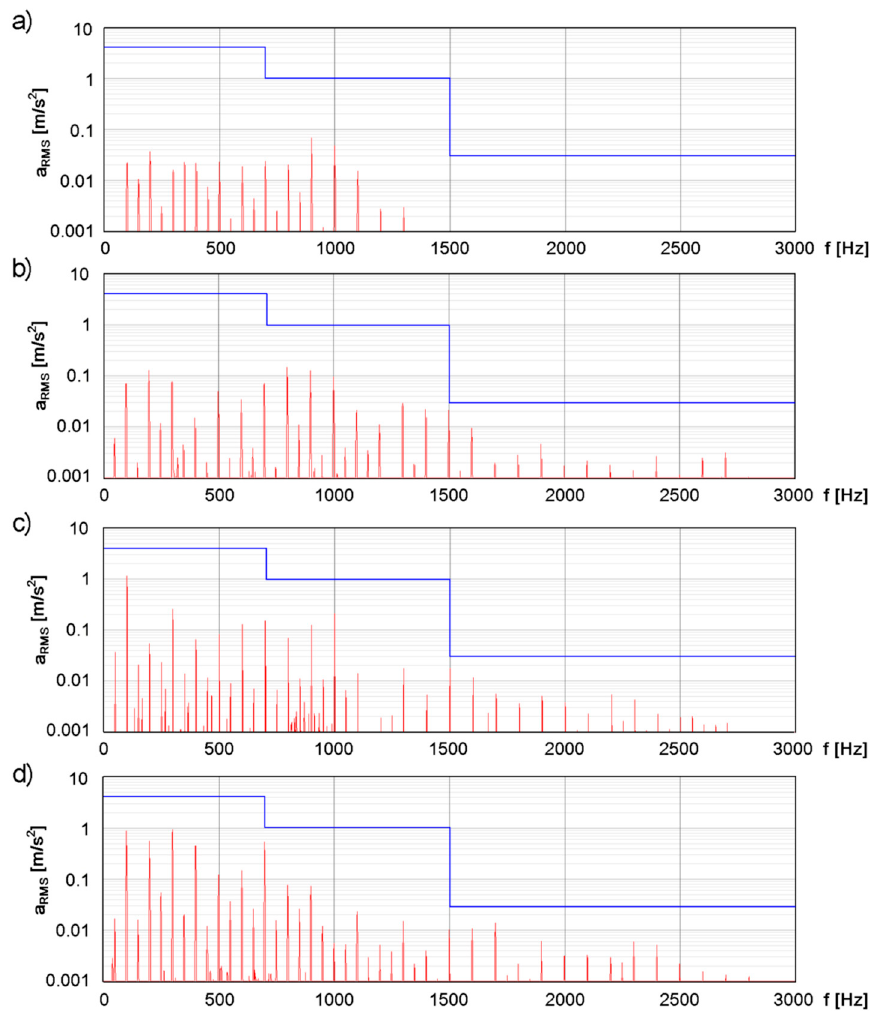
Figure 7. Comparison of frequency spectra (in the range 0–3000 Hz) of four transformers with rated power of 16 MVA for the same measuring point (A2): ( a ) new transformer; ( b ) transformer which has been in use for 23 years; ( c ) transformer which has been in use for 41 years; ( d ) transformer which has been in use for 49 years. The criteria values (Table 2) are marked by blue lines.